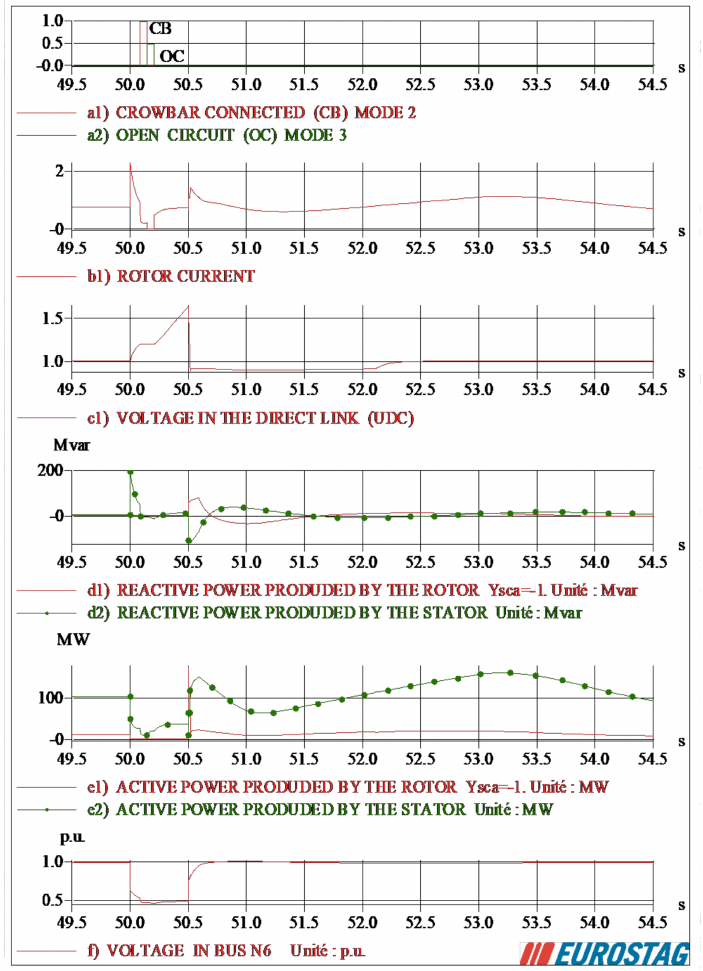
Figure 7. Dynamic analysis of the protection model crowbar without a